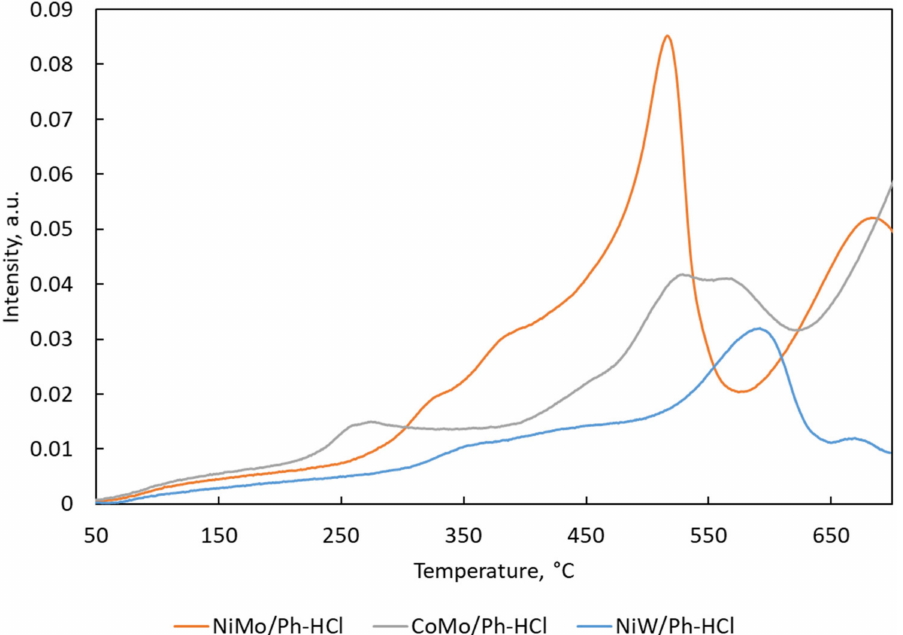
Figure 2. H 2 -TPR patterns of acid Ph-derived catalysts (NiMo/Ph-HCl, CoMo/Ph-HCl, and NiW/Ph-HCl).